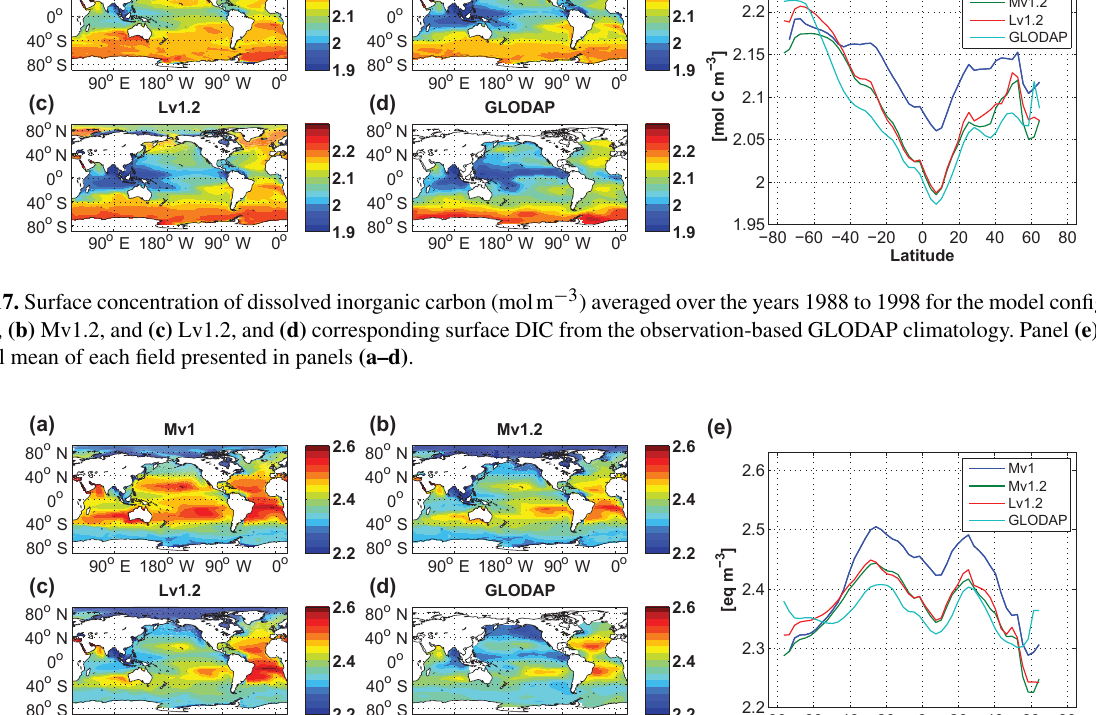
influence the calculation of trends. Results for the different model versions and configurations forced with NCEP-C-IAF and CORE-IAF are shown in Fig. 20.